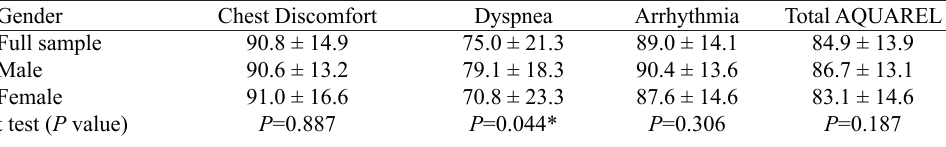
Table 2. Mean values for quality of life from the AQUAREL questionnaire for full sample and comparison of domains according to gender (t test).